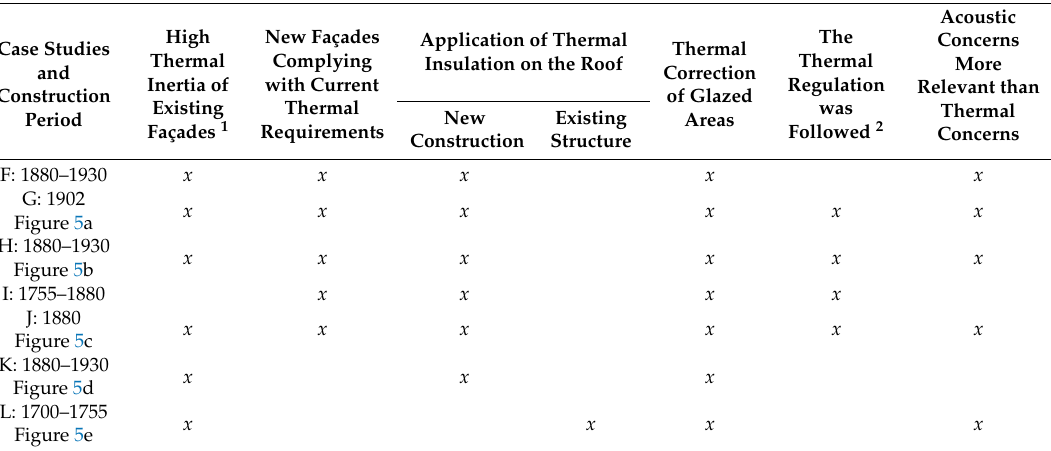
Table 3. Summary of the critical analysis of case studies F to